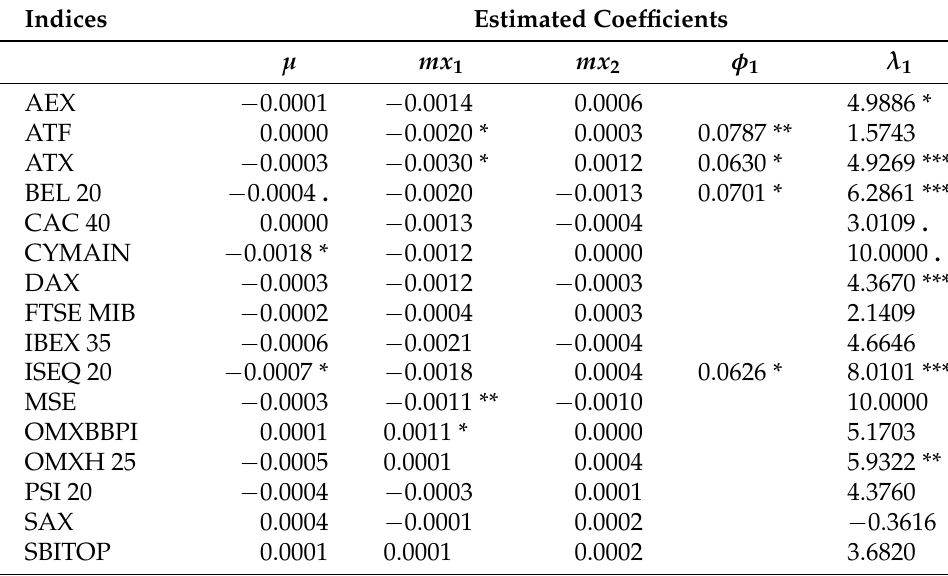
Table A3. Results of Conditional Mean Equation.